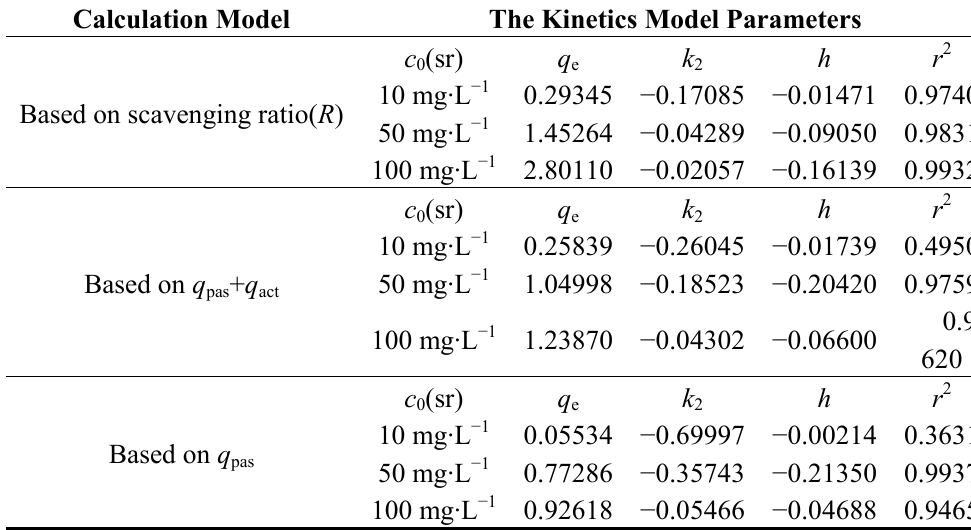
Table 3. The kinetic model